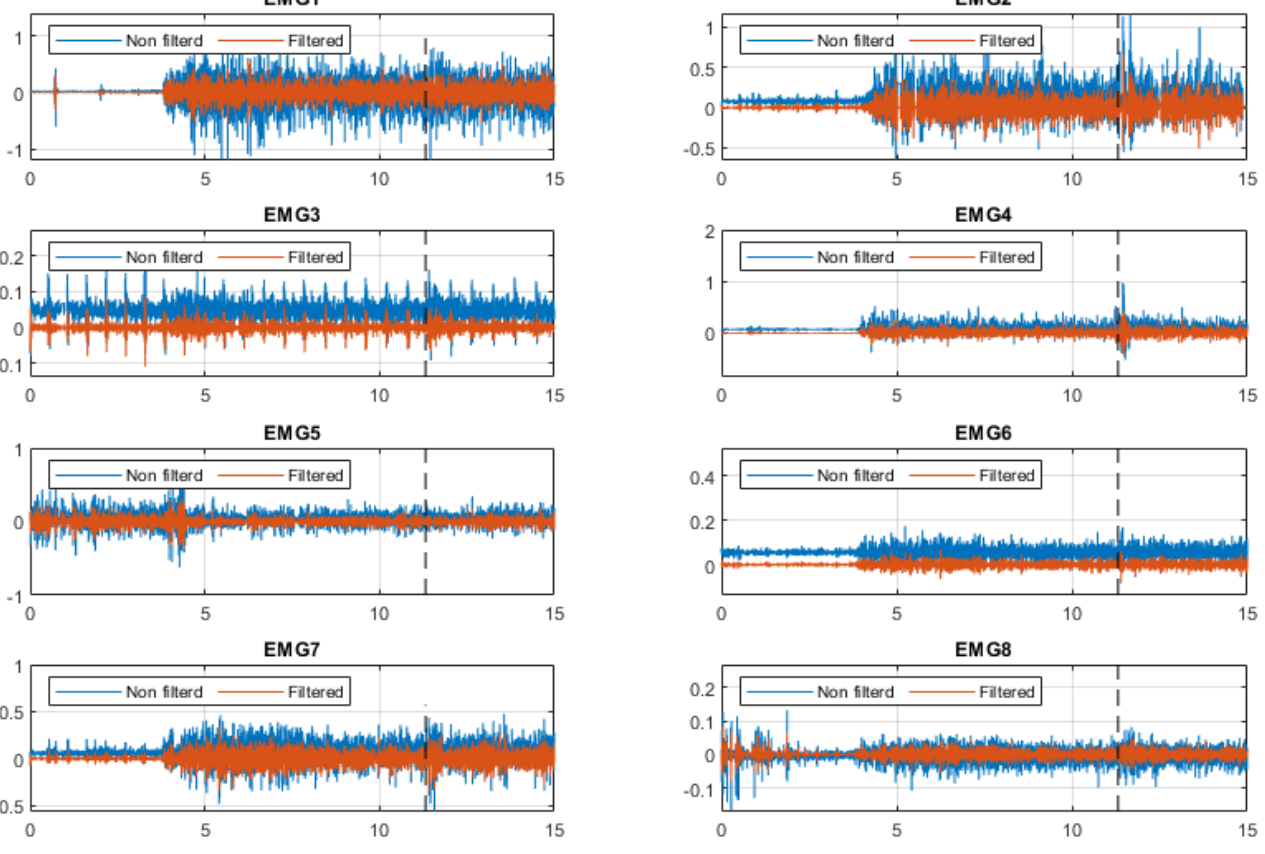
Figure 3. Raw and band pass filtered EMG data for one trial of subject number 7. EMG1 to EMG8 represent Deltoid Anterior, Pectoralis Major Clavicular, Pectoralis Major Sternal, Biceps Brachii, Trapezius Descending, Deltoid Posterior, Latissimus Dorsi and Triceps Brachii, respectively. The black dashed line represents the perturbation instant.